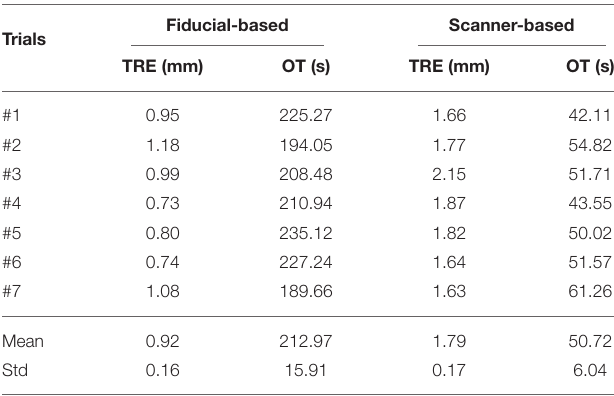
TABLE 4 | Results of different registration